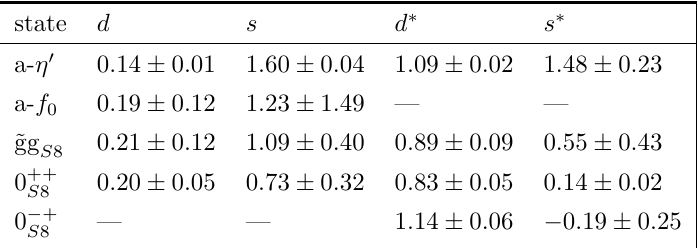
Table 5 . Results of the linear fits. The lowest mass contribution d , the next higher mass contri- bution d ∗ , the corresponding slopes s resp. s ∗ and their fit errors are rounded to 2